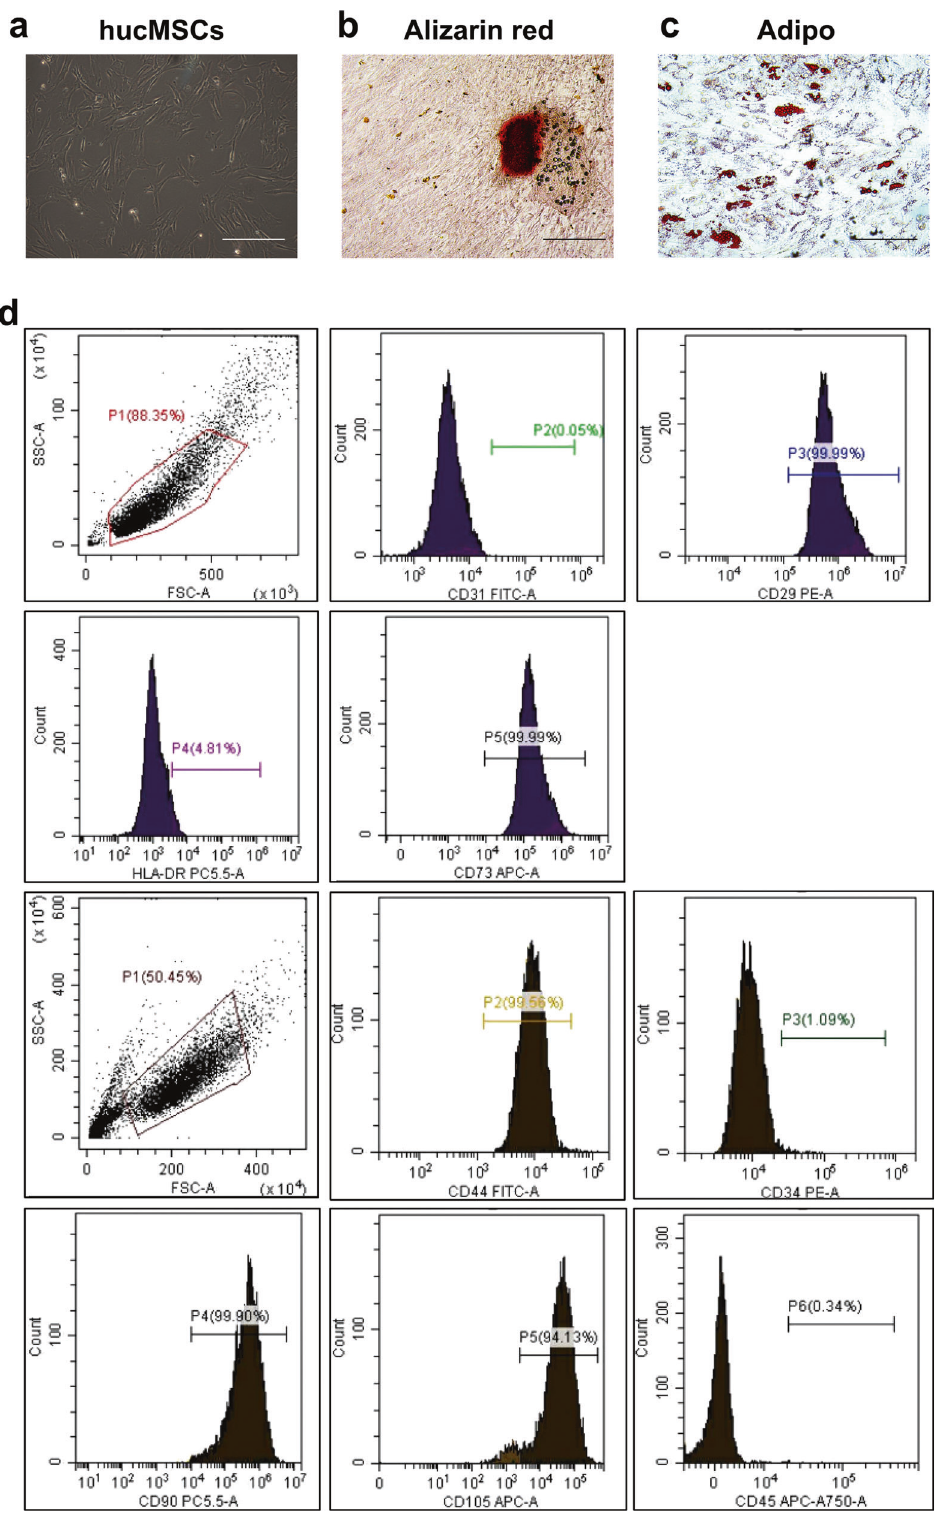
Fig. 1 hUCMSCs morphological characterization and expression pro fi le. a Spindle-shaped morphology of hUCMSCs (bar = 50 µm). b Osteogene-derived hUCMSCs (bar = 200 µm). c adipose-derived hUCMSCs (bar = 50 µm). d Fluorescence activated cell sorting (FACS) analysis of hUCMSCs with positive CD44, CD90, CD105, CD29, CD73, and negative CD34, CD45, CD31 and HLA-DR ( n = 6, p <